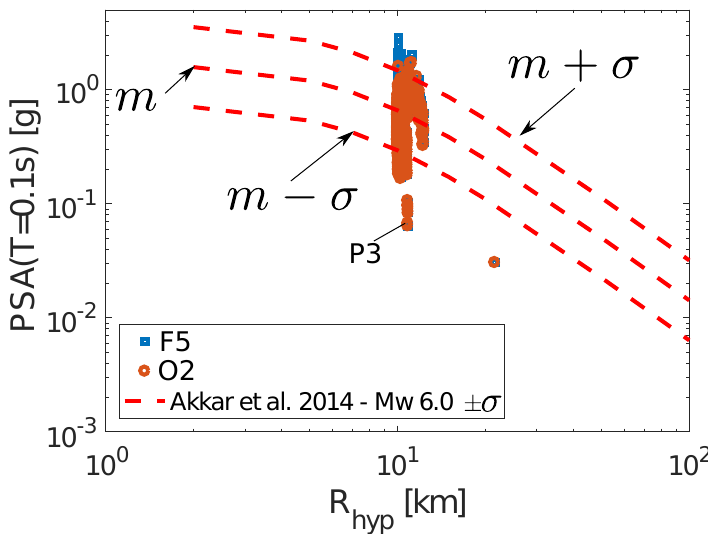
Figure 12. Comparison between SEM3D numerical simulations F5 (homogeneous) and O2 (hetero- geneous) and the GMPE proposed by [104]. Pseudo Spectral Acceleration ( PSA ) at natural period T = 0.1 s is plotted against hypocentral distance R hyp . m : median ln ( PSA ) ; m plus/minus standard deviation σ . Three horizontal grids of points, located at 0 m G.L., and 150 m G.L. were considered. Records were low-pass filtered at 10 Hz before computing PSA . − Both the M W 6.0 simulations comply with the GMPE proposed by Akkar et al.